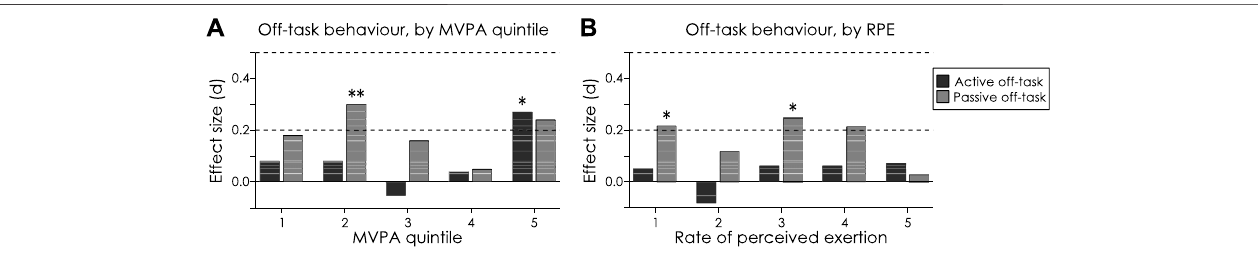
FIGURE 3 | Change in off-task behaviour in response to physical activity intensity. (A) Off task behaviour, MVPA quintile (B) Off-task behaviour, by RPE. Note. MVPA (cid:1) Moderate-to-vigorous physical activity. Effect sizes have been transformed so that positive numbers re fl ect favourable effects (less off-task behaviour). Small ( d (cid:1) 0.2), medium ( d (cid:1) 0.5), and large ( d (cid:1) 0.8) effect sizes are indicated by the dashed grid lines. * p ≤ 0.05, ** p ≤ 0.01, and *** p ≤